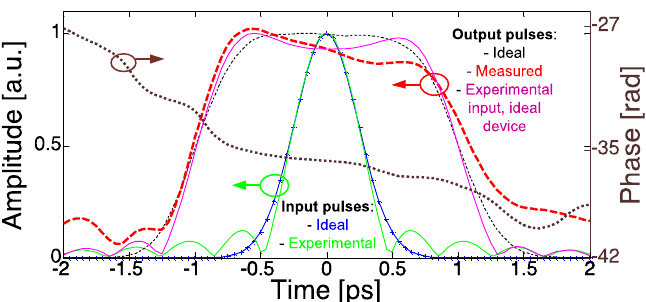
Figure 12. Ideal temporal input pulse (blue line) and pulse employed in the characterization of a flat-top pulse shaper implemented on a FBG in transmission (green line); Ideal temporal output (black line) and experimentally measured output (red line). The output signal from the input employed in the experimental test (green line) and the ideal device response is also plotted (magenta line), to show deviations from the ideal output owing to the employed pulse.